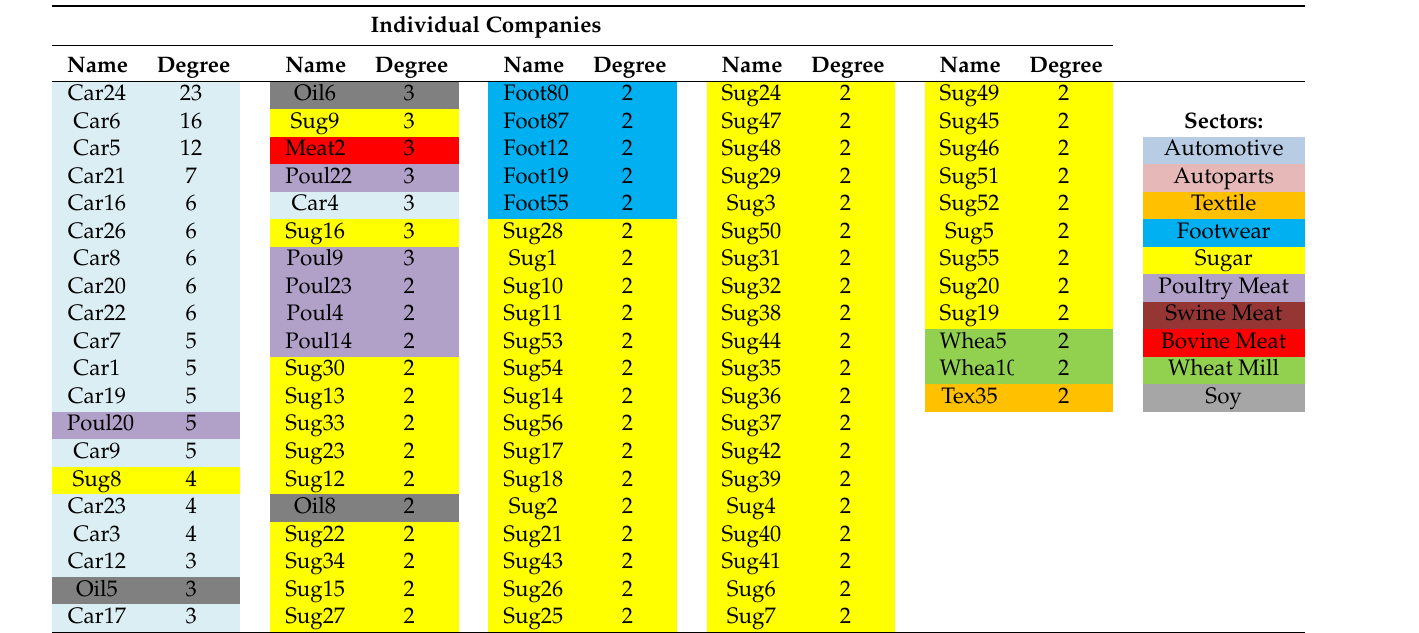
Table A3. Individual companies’ degree centrality by economic subsector.